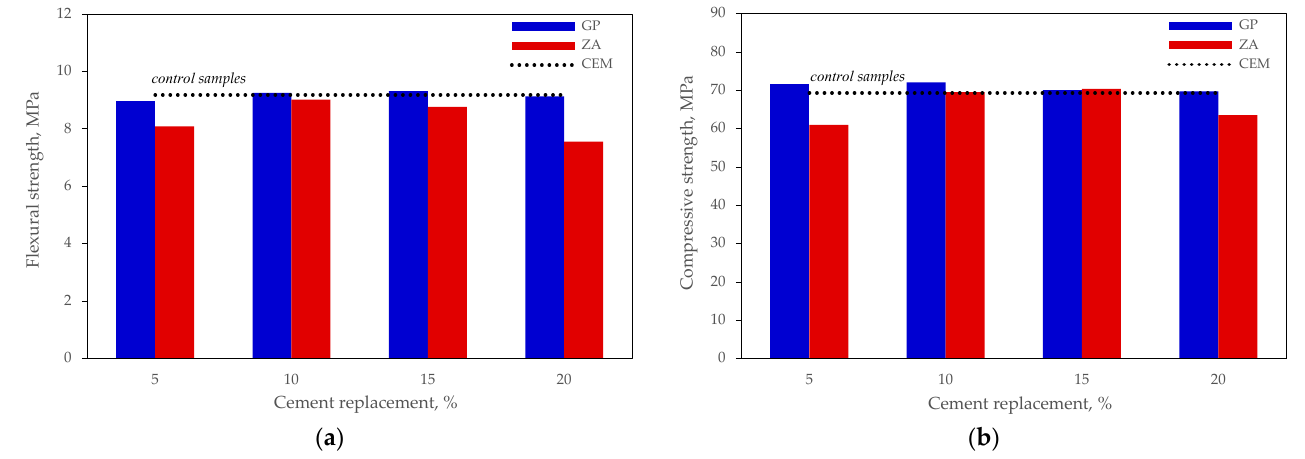
Figure 6. Results of the mechanical tests of mortars No 1 after 90 days: ( a ) flexural strength; ( b ) compressive strength.